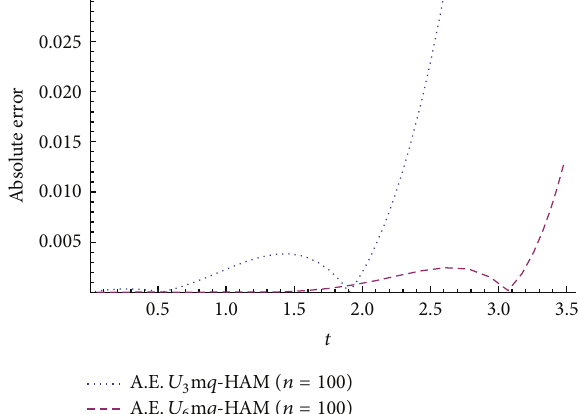
Figure 12: The absolute error of 𝑈 6 of 𝑛 HAM (m 𝑞 -HAM; 𝑛 = 1) and 𝑈 6 of m 𝑞 -HAM ( 𝑛 = 5,20, 50, 100) for problem (40) at 𝑥 = 1 using (ℎ = −1,ℎ = −4.85, ℎ = −18.55, ℎ = −43.11, ℎ = −79.5) , respectively.